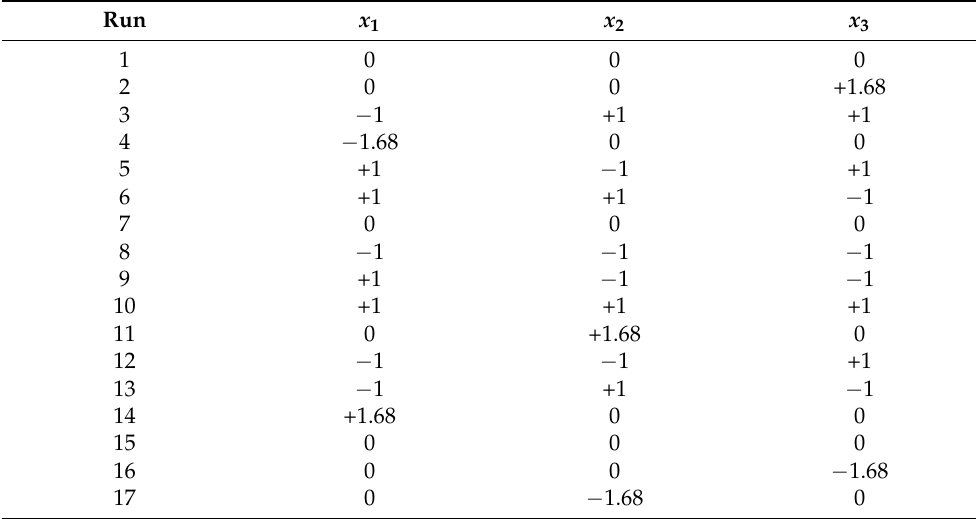
Table 2. Central composite rotatable design (CCRD)